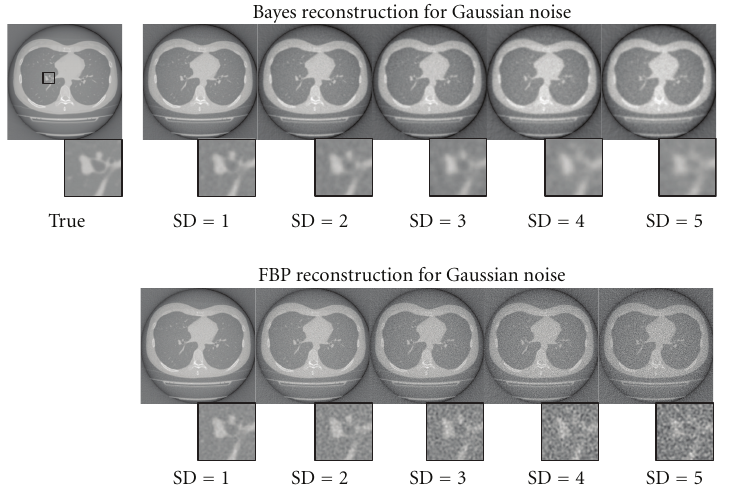
Figure 7: Comparison of the reconstructed images using real CT data with Gaussian noise between Bayes method and conventional FBP method. The top row shows the results of our method, and the bottom one shows the conventional FBP results. Each column corresponds to the strength of the observation noise that can be denoted as standard deviation (SD) of adding noise. We also show the magnification of a part around the bronchus, whose location is indicated by black rectangle in the true image.